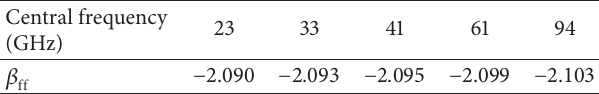
Table 3: Spectral index of the free-free emission at the WMAP frequencies assuming an electronic temperature of 𝑇 𝑒 = 8 000 K. Central frequency